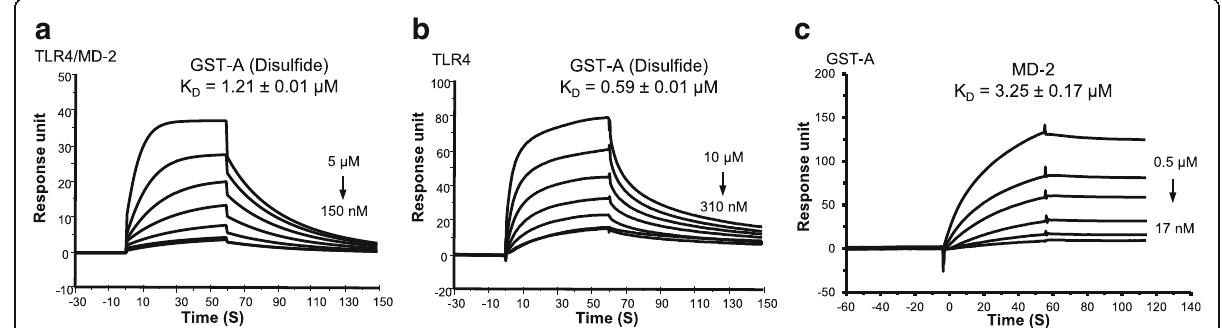
Fig. 3 SPR analyses of GST-A-box binding to TLR4/MD-2, TLR4 and MD-2. a TLR4/MD-2 complex was coated on the CM5 chip, GST-A-box binds to complex with a K D of 1.21 ± 0.02 μ M. b TLR4 was coated on the chip, GST-A-box binds to TLR4 with a K D of 0.59 ± 0.01 μ M. c GST-A-box was coated on the CM5 chips, MD-2 was used as analyte, MD-2 binds to GST-A-box with a K D of 3.25 ± 0.17 μ M. GST tag was used as negative control. Data are representative of three